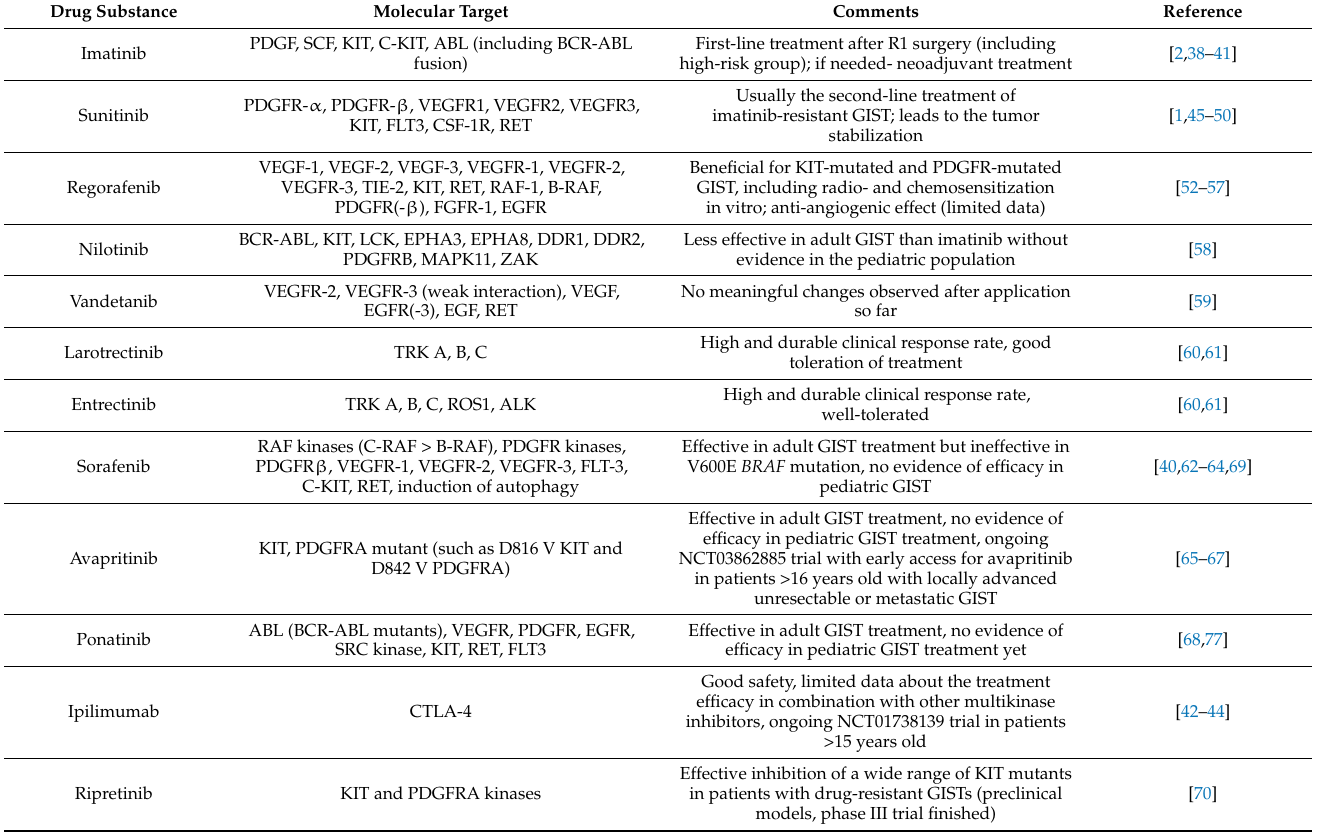
Table 1. Current application and perspectives in targeted therapies in pediatric GISTs